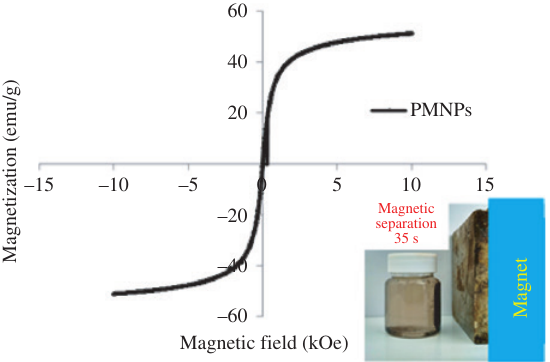
Figure 10: The thermal gravimetric analysis (TGA) plot/curve of the phytogenic magnetic nanoparticles (PMNPs). Reproduced from Ali et al. (2018) with permission from Royal Society of Chemistry,